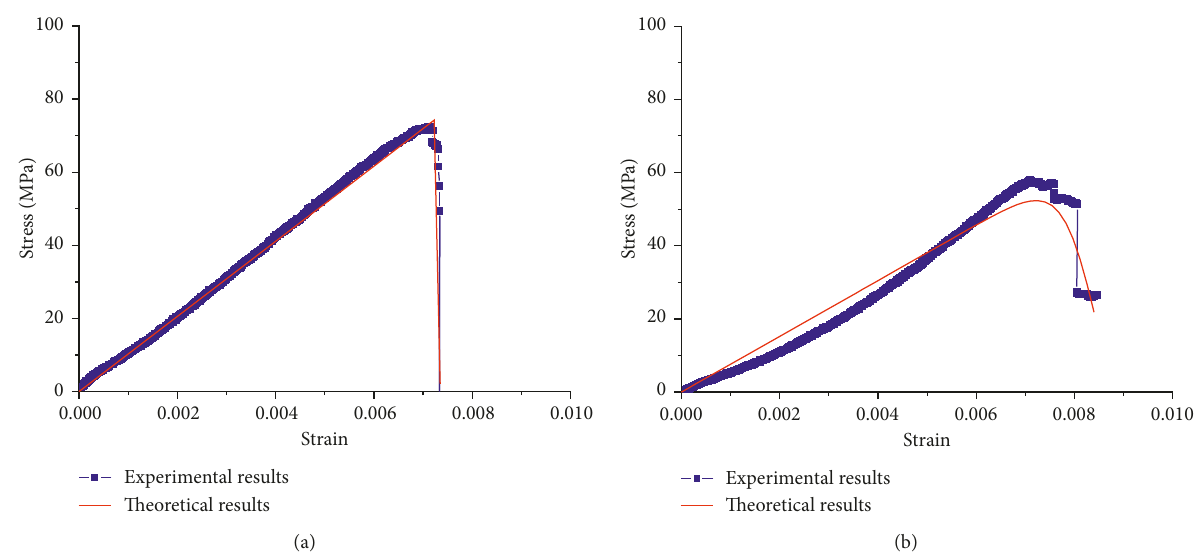
Figure 6: Comparisons of experimental and theoretical results. (a) Specimen number 10. (b) Specimen number